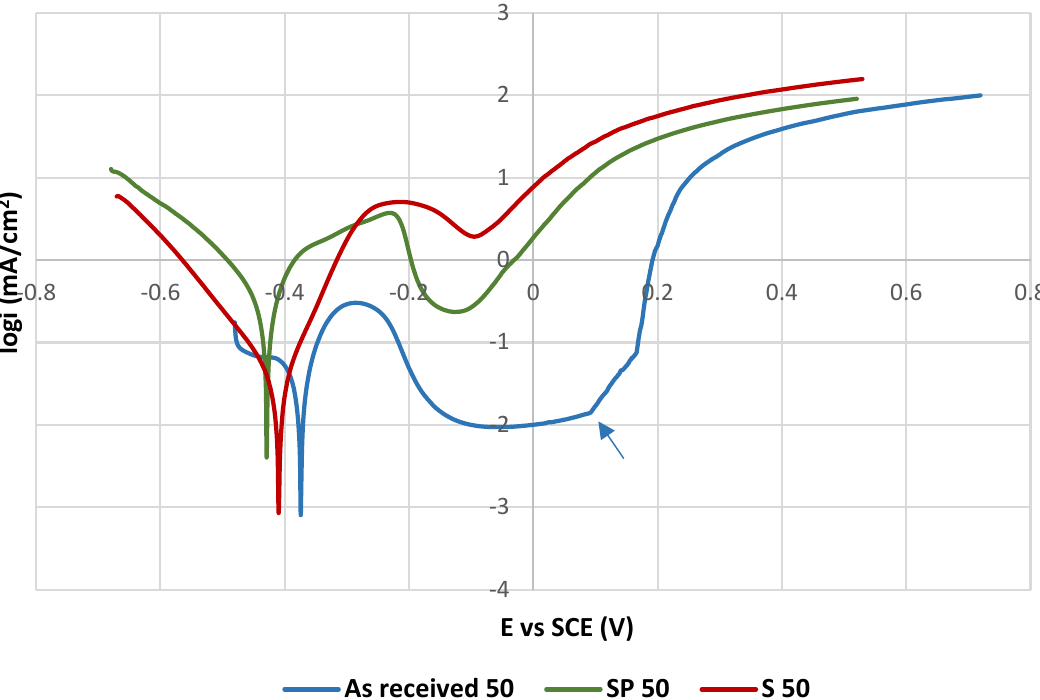
Figure 4. Potentiodynamic polarization curves for tested specimens at 50 °C. The pitting potential E p related to the as received 50 curve is marked by the arrow.